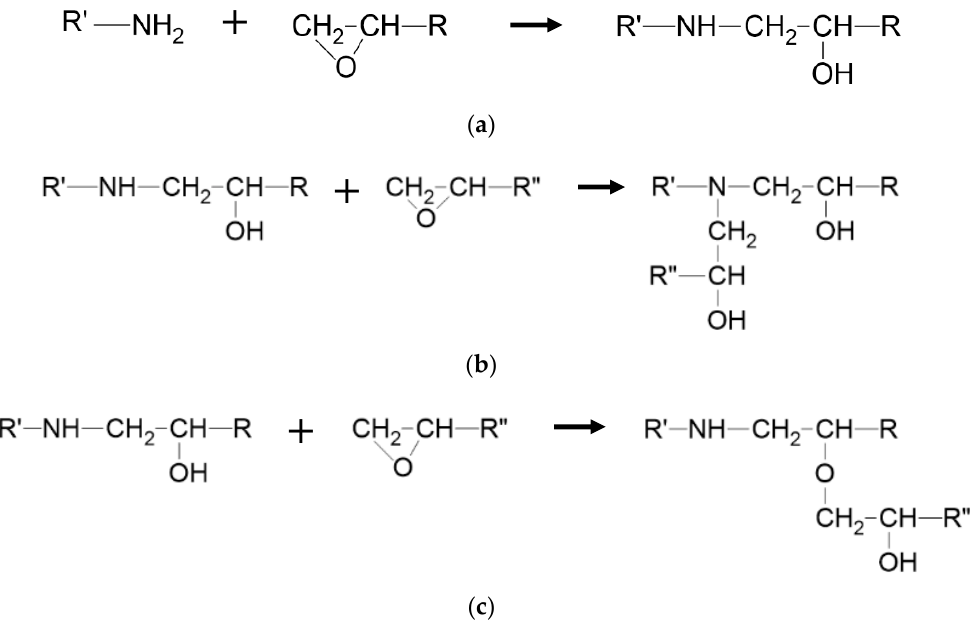
Figure 1. Models of amine addition to form secondary ( a ) and tertiary amine ( b ). Etherification is depicted in ( c ).